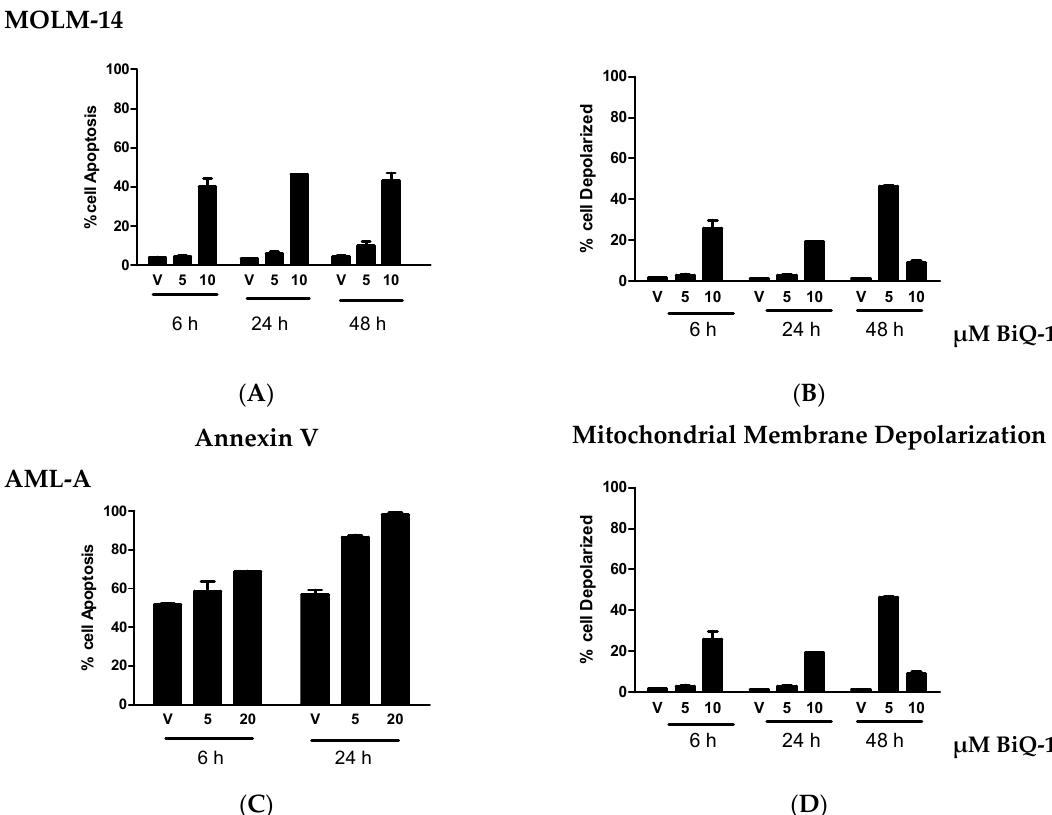
Figure 3. BiQ-1 induced apoptosis and mitochondrial membrane depolarization, as measured by annexin V and MitoPotential-Red. ( A , C ) MOLM-14 and ( B , D ) AML-A cells were treated with 5–20 µM of BiQ-1 and cells were collected and analyzed by flow cytometry 6, 24 and 48 h after exposure. * p < 0.05 compared to vehicle. Representative data is shown.